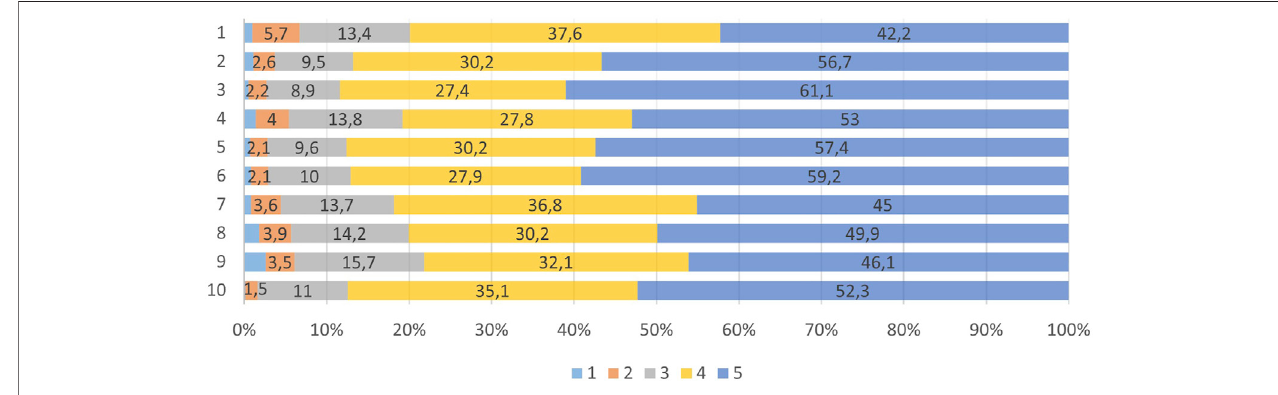
FIGURE 1 | Description of the resources. Block IV.2. of the